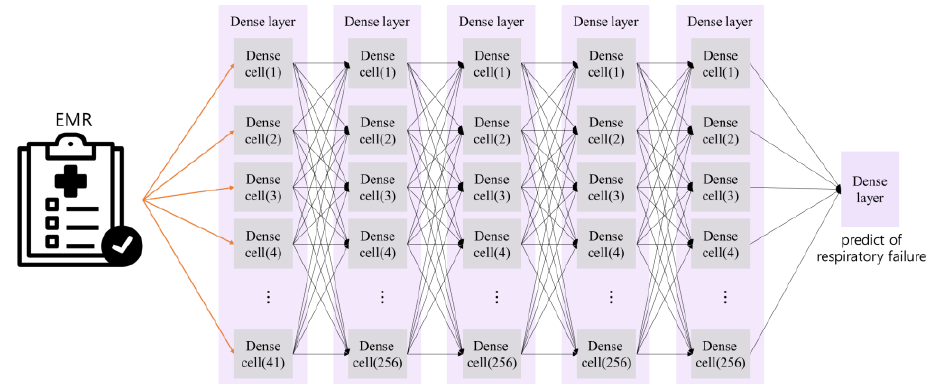
Figure 12. Structure of MLP in this paper. The number of units in hidden layer is 256.